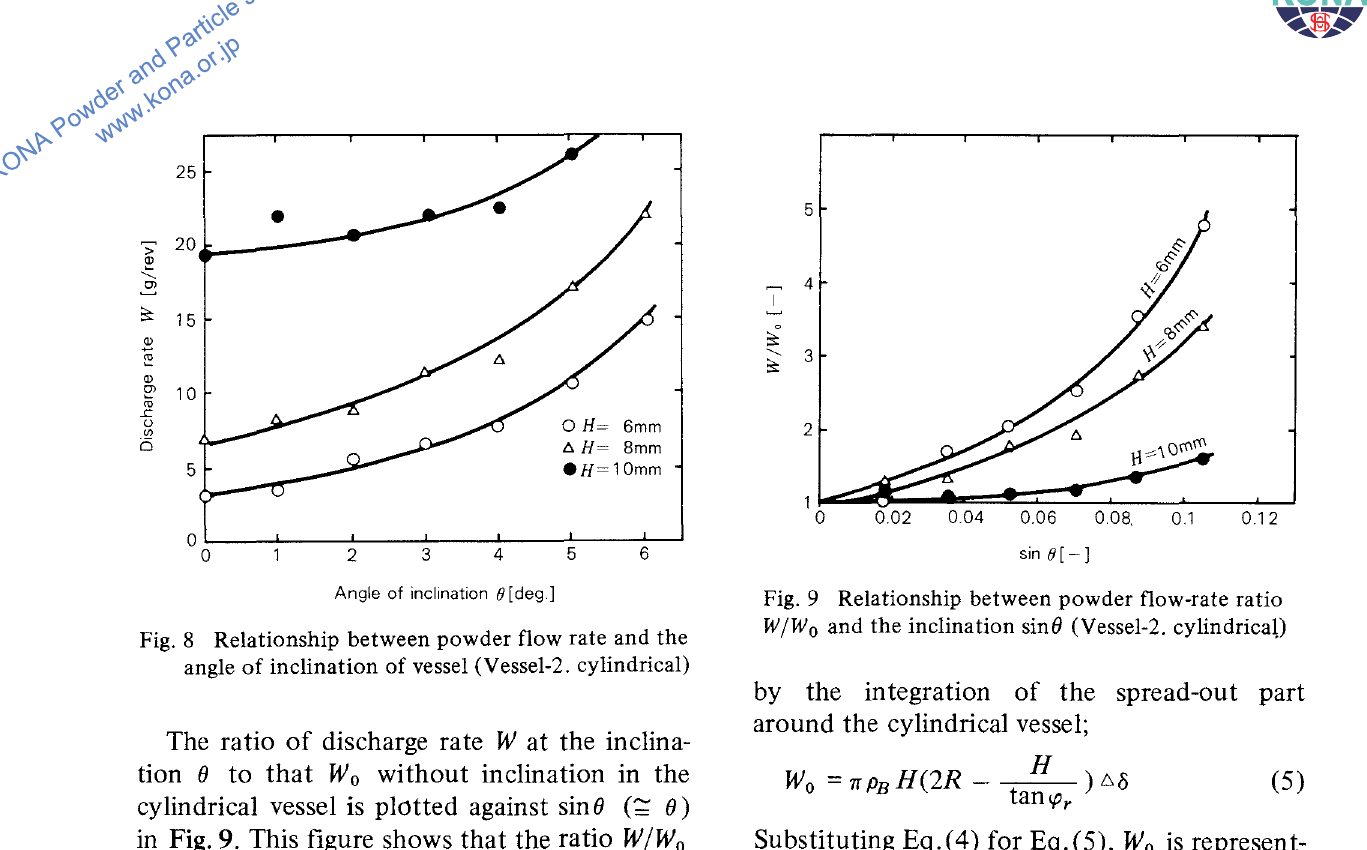
Fig. 8 Relationship between powder flow rate and the angle of inclination of vessel (Vessel-2. cylindrical)